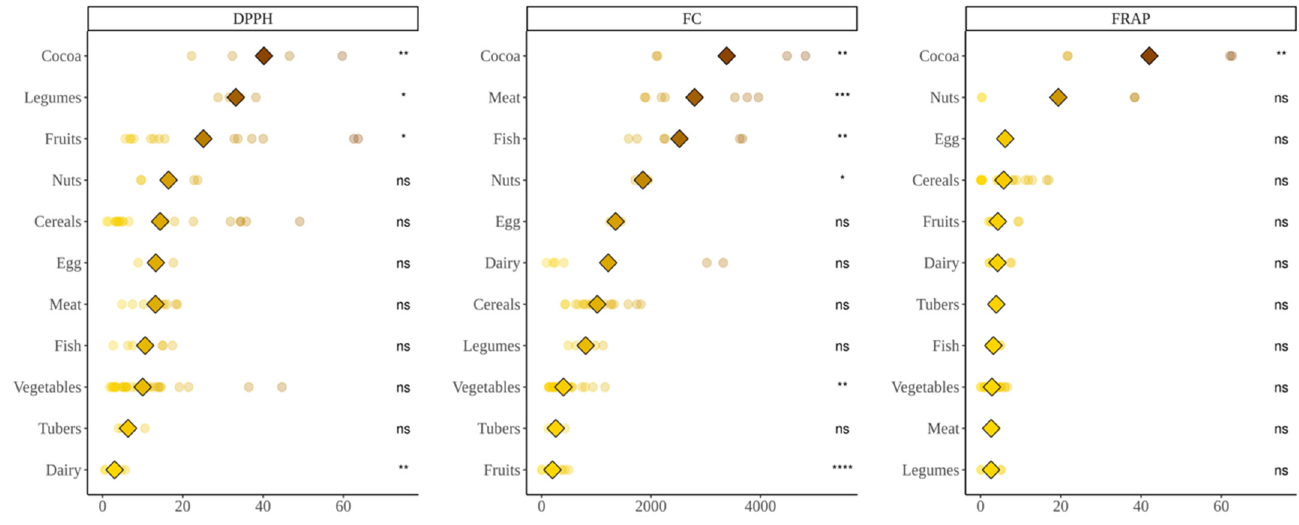
Figure 1. Antioxidant capacity of food obtained after in vitro digestion of selected foods. DPPH expressed as mmol Trolox equivalents/kg(L) of food; Folin–Ciocalteu (FC) expressed as mg equivalents of gallic acid/kg(L) of food; FRAP expressed as mmol Trolox equivalents/kg(L) of food. Diamonds represent the mean antioxidant capacity of each group. Dots represent the antioxidant capacity of each food within the group. Statistical analysis was performed via Kruskal–Wallis test. Each of the groups were compared to the average of all of them (i.e., base-mean). Statistic labels: *: p < 0.05, **: p < 0.01, ***: p < 0.001, ****: p < 0.0001, ns: not significant.